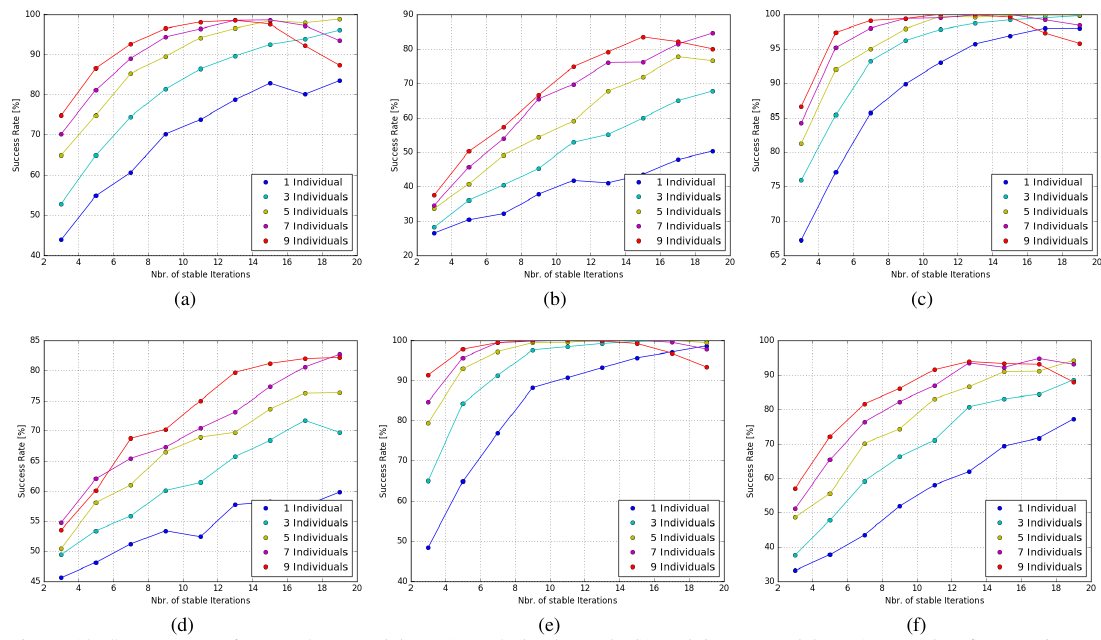
Figure 12. Success Rate for WV-2 (Roundabout 1 (a), 2 (b), 3 (c), 4 (d)) and QB (Roundabout 1 (e) and 1 (f)) experiments co-registration software for multi-sensor satellite data. Remote Sensing